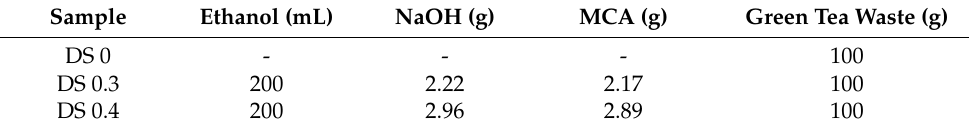
Table 1. Information on various DS of cellulose nanofibrils from green tea